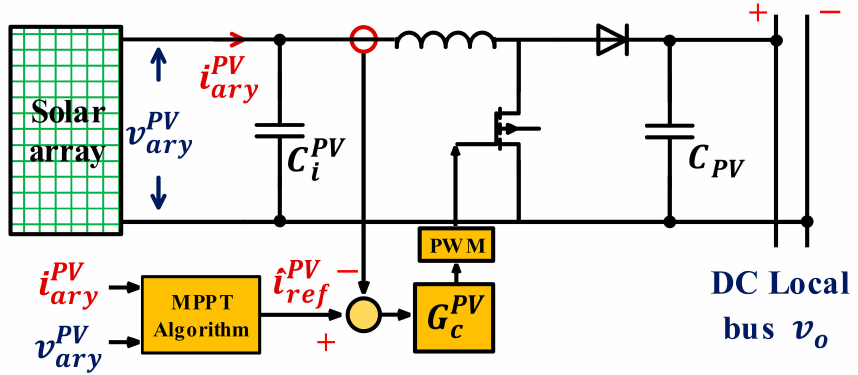
Figure 9. Block diagram of a PV solar array with boost converter and controller.